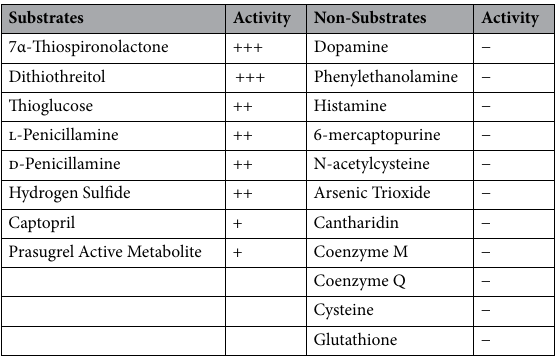
Table 1. Relative methylating ability of His-GST-METTL7B with different probe substrates.